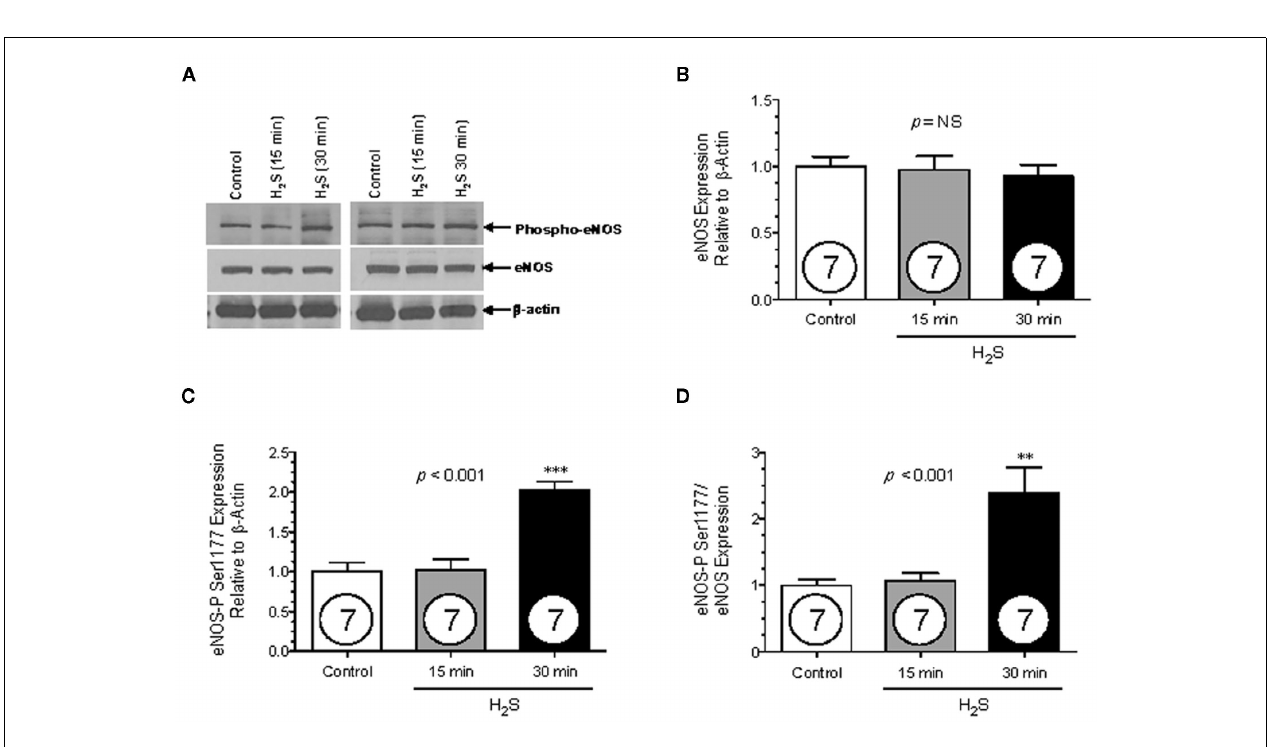
phosphorylated at Ser 1177 expression over total eNOS expression. Statistical analysis was performed using a one-way ANOVA (ANOVA p -value is in center of figure) with Dunnett’s post hoc test. Numbers inside circles denote the N for each column. An asterisk denotes